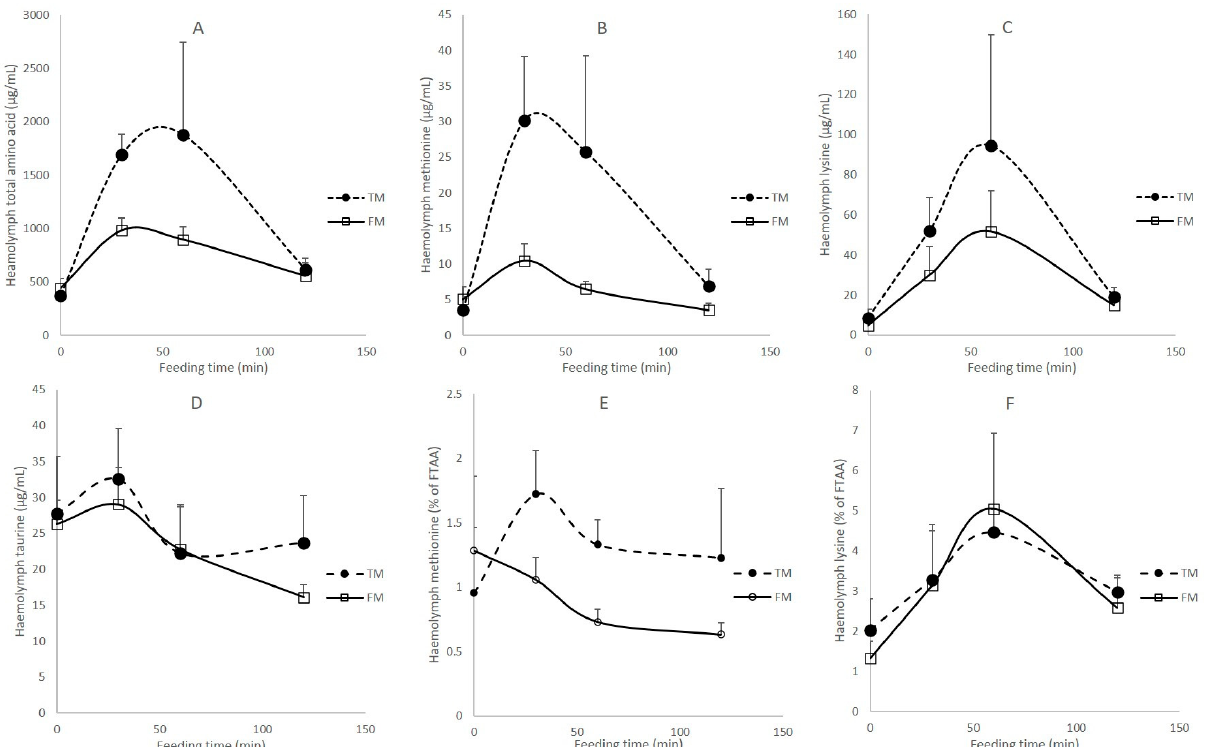
Figure 5. Haemolymph amino acid (µg mL − 1 ) in shrimp fed two diets over time (min). ( A ) Free total amino acid (TAA) concentration; ( B ) free methionine concentration; ( C ) free lysine concentration; ( D ) taurine concentration; ( E ) free methionine in proportion to TAA (%); ( F ) free lysine in proportion to TAA (%). Note, all shrimp were given the same ration in terms of percentage body weight.